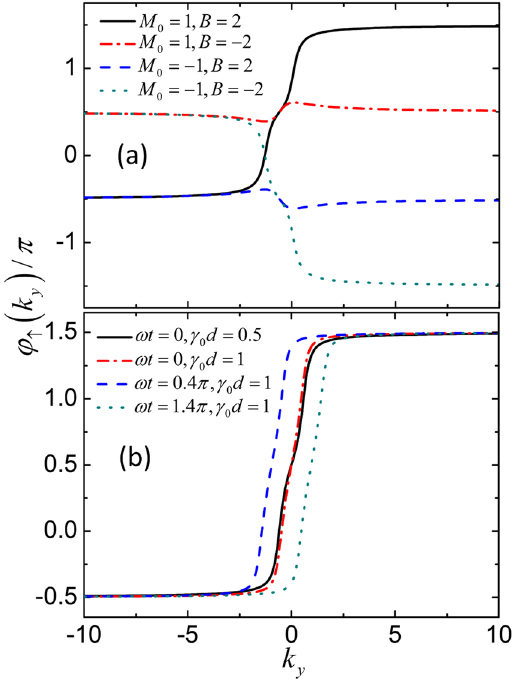
Figure 2. Argument of the complex reflection amplitude, ϕ = ↑ ↑↑ k r ( ) arg( ) different sets of ( M 0 , B ), and ( b ) four sets of ( ω t , γ 0 d ). The other parameters are taken to be eE 0 / ω = 1, and ( a ) = 0, ( b ) M = 1, B = 2. The unit set is v ω t = γ 0 d 0